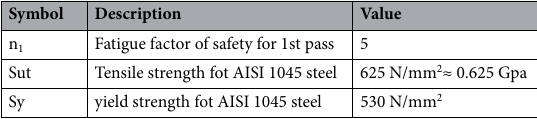
Table 5. Parameter for shaft